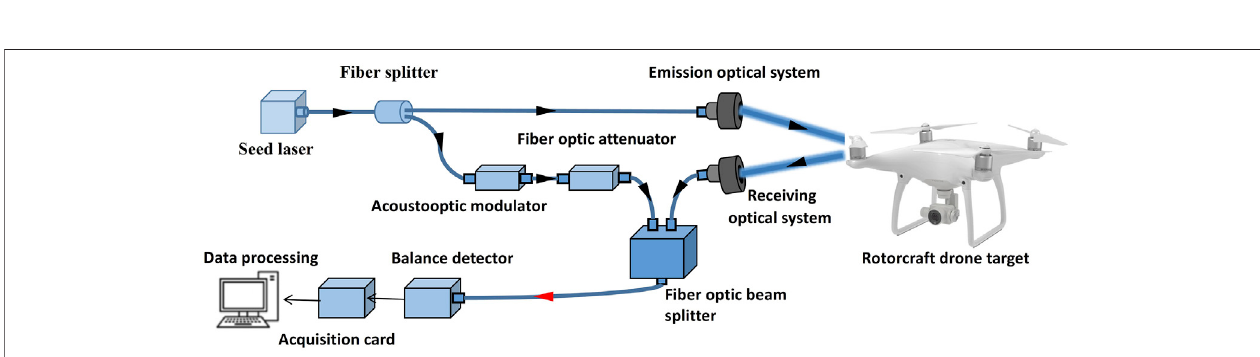
FIGURE 5 | Schematic diagram of the rotor blade echo